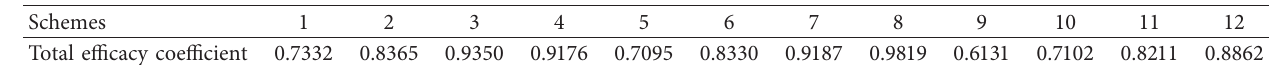
Table 9: Total efficacy coefficient of comprehensive performance.